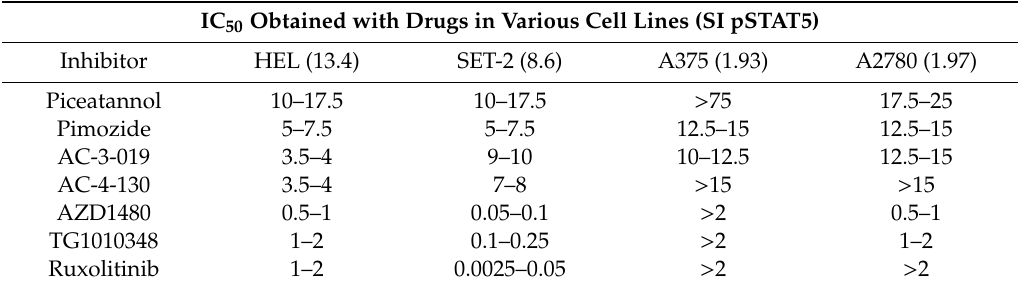
Table A3. IC 50 concentrations of JAK2- and STAT5 targeting drugs in pSTAT5 high and low cell lines. IC 50 Obtained with Drugs in Various Cell Lines (SI pSTAT5)